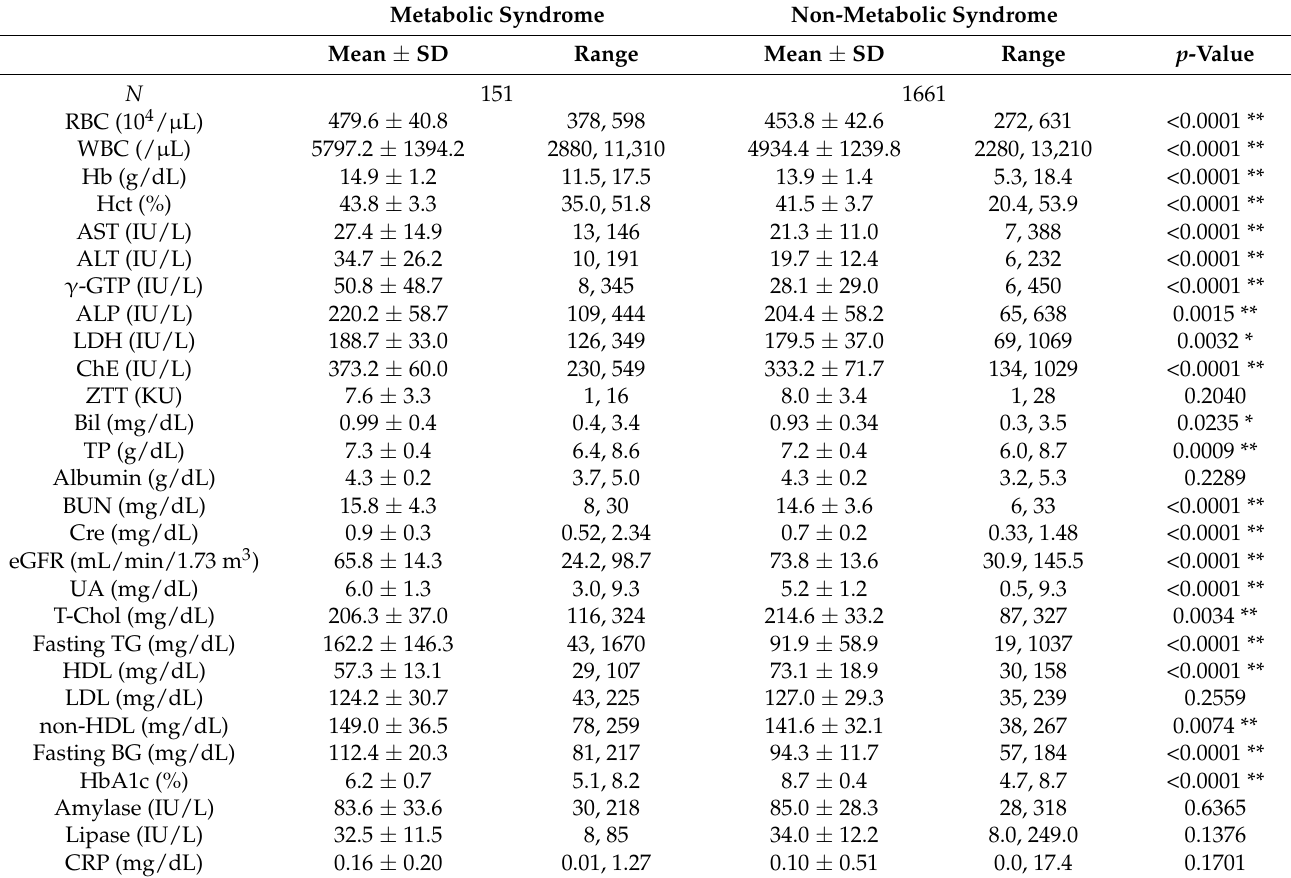
Table 2. Summary of laboratory data of study subjects with and without metabolic